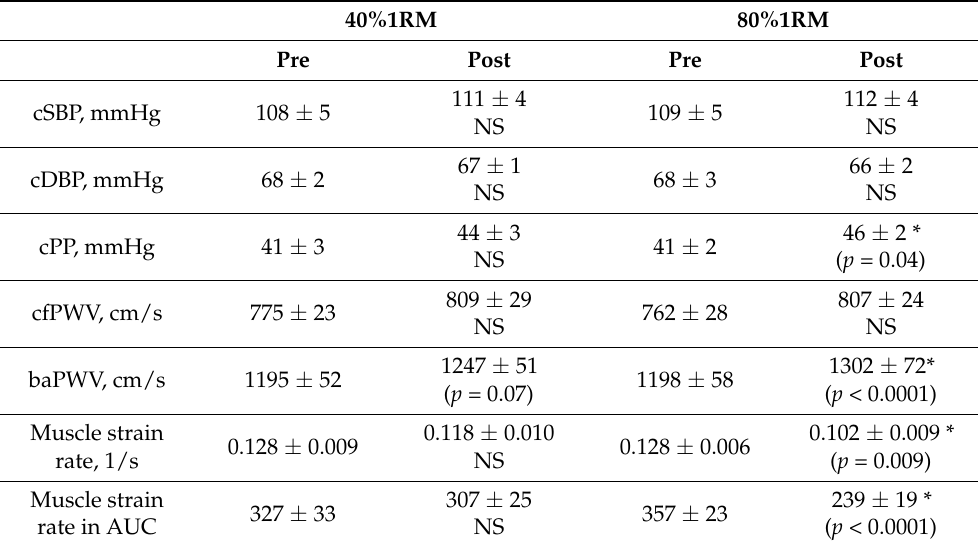
Table 2. Central blood pressure, pulse wave velocity, and muscle strain changes pre- and post- exercise.